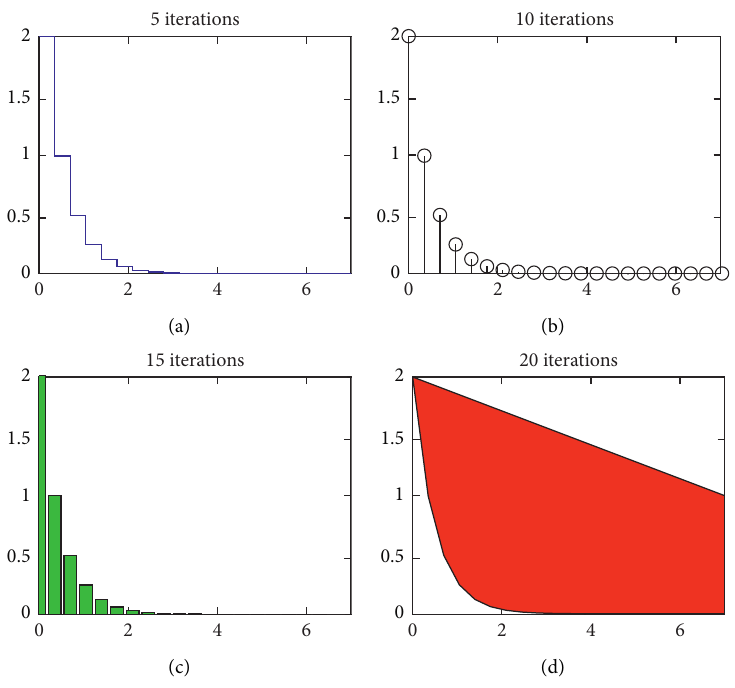
Figure 8: Comparison of MAE on different iterations.